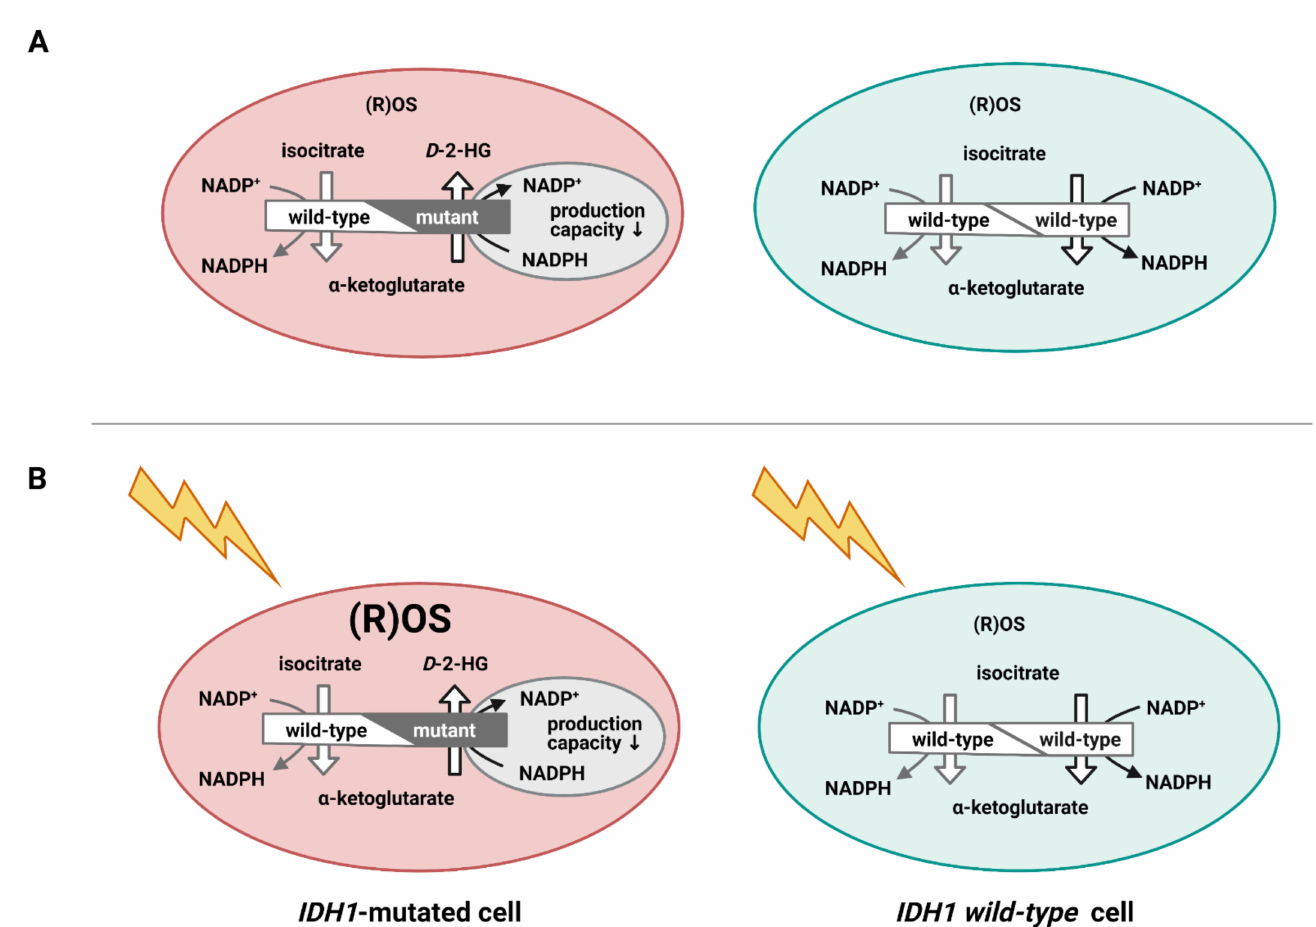
Figure 3. Cartoon of isocitrate dehydrogenase 1 ( IDH1 ) wild-type cells (blue) and IDH1 -mutated cells (pink) showing the functional IDH1 dimer of 2 wild-type alleles and of one wild-type allele and one mutated allele. The wild-type dimer produces α -ketoglutarate and NADPH and the heterozygous mutated dimer produces d-2-hydroxyglutarate (D-2-HG) and NADP + . Reactive oxygen species (ROS) levels are in a steady state more or less similar in both cancer cells ( A ), whereas ROS levels accumulate in the IDH1 -mutated cell due to irradiation because of reduced NADPH production, unlike in the wild-type cancer cell ( B